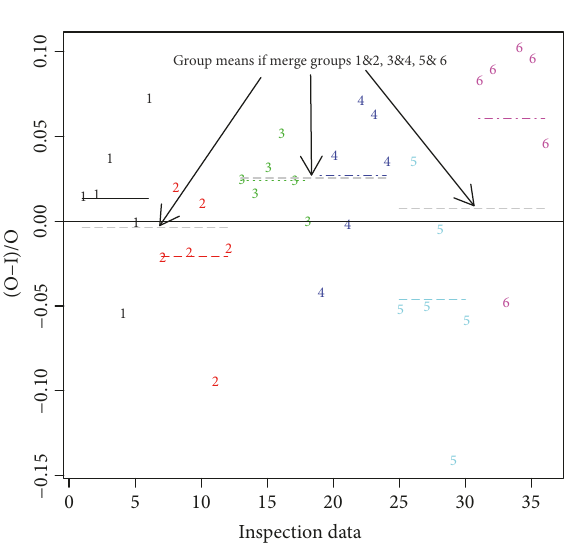
Figure 3: Illustration of incorrectly merging successive